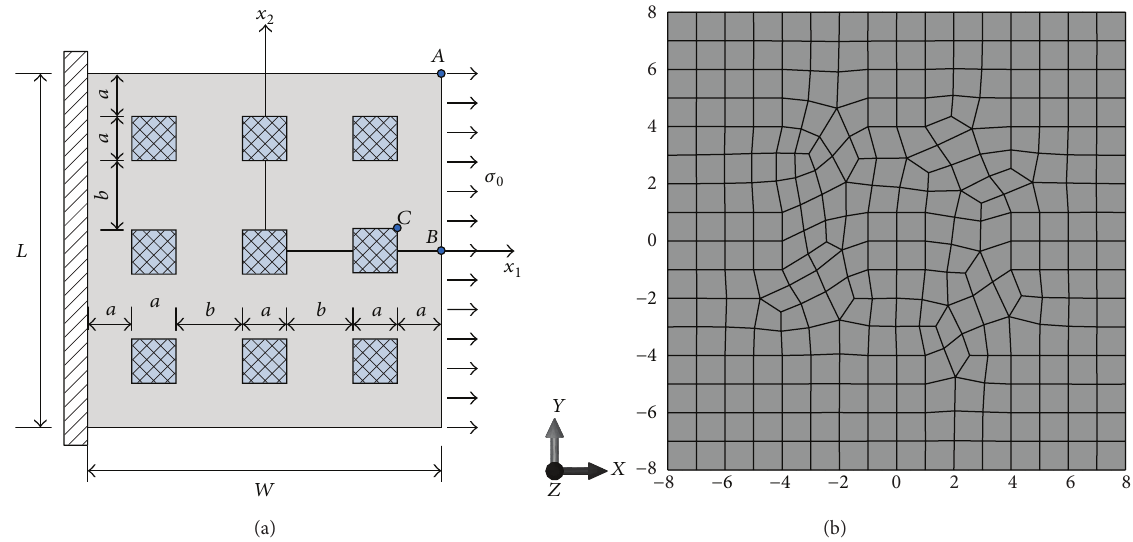
Figure 21: (a) Schematic and (b) mesh configuration of an isotropic plate with multianisotropic inclusions.